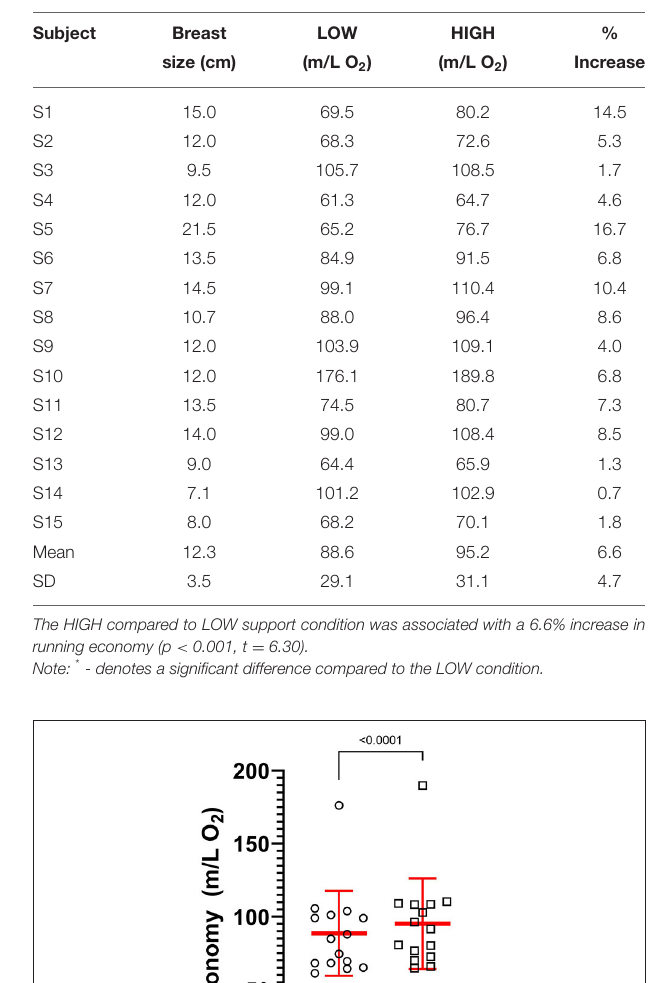
TABLE 3 | Running economy values for each participant measured as the distance traveled per liter of oxygen consumed.